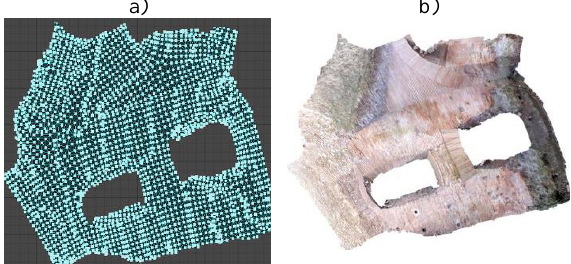
Figure 2: UV map after remeshing (a) and texturing (b) for the Cavea – Circus Maximus case